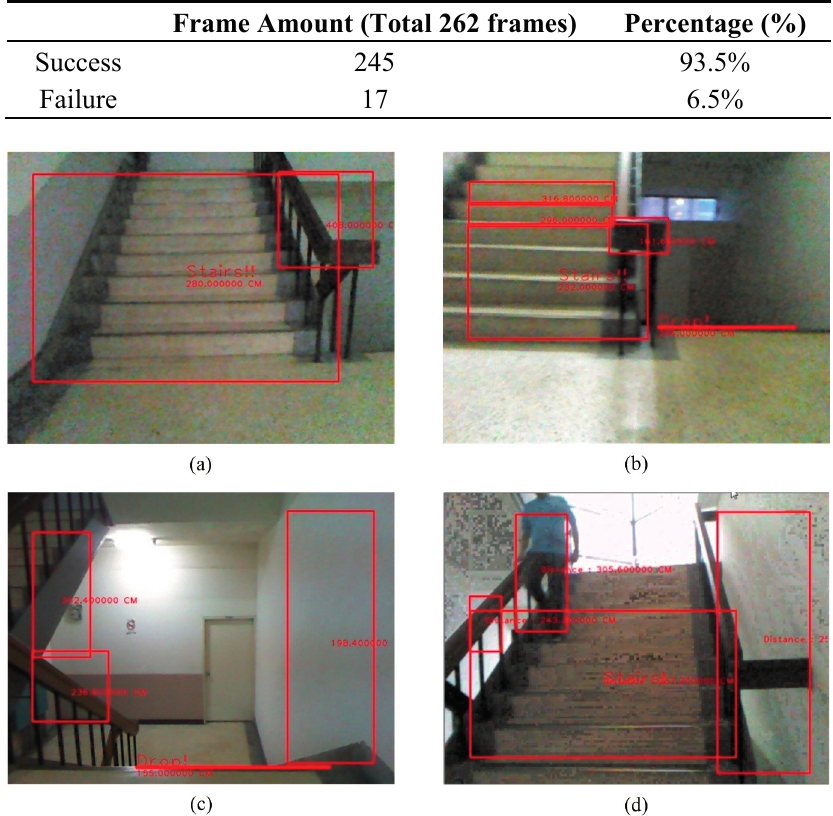
Table 3. The success rate and the failure rate for obstacle detection.